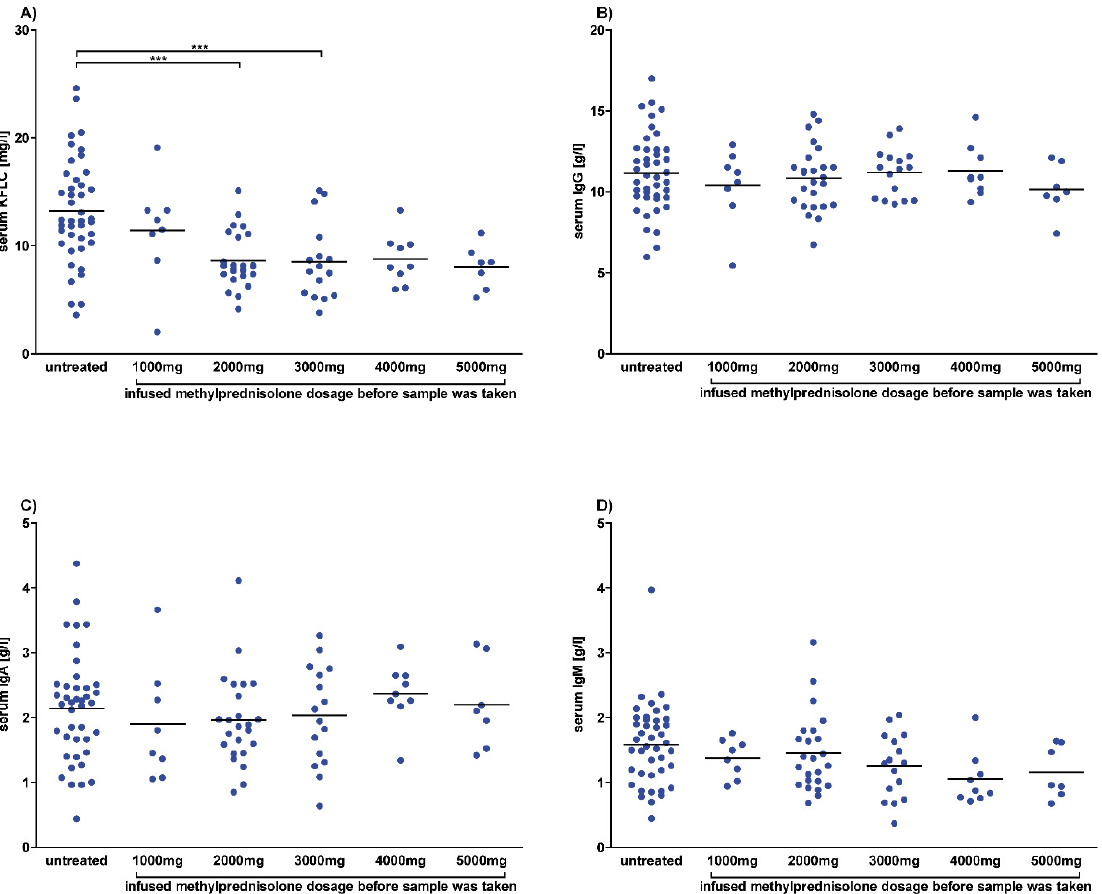
Figure 1. Serum concentrations after methylprednisolone. Serum concentrations of patients diagnosed with multiple sclerosis according to the McDonald criteria of 2017 and clinically isolated syndrome who converted to multiple sclerosis during follow-up. Each dot represents a single measurement of a patient who was untreated or received intravenous methylprednisolone with the indicated dose. Depicted are serum concentrations of kappa free light chains (KFLC) ( A ), immunoglobulin type G (IgG) ( B ), IgA ( C ), and IgM ( D ) in untreated patients (n = 42) and patients who received methylprednisolone infusion of 1000 mg (n = 8), 2000 mg (n = 25), 3000 mg (n = 16), 4000 mg (n = 9), or 5000 mg (n = 7). p -values of significant differences are illustrated as asterisks.